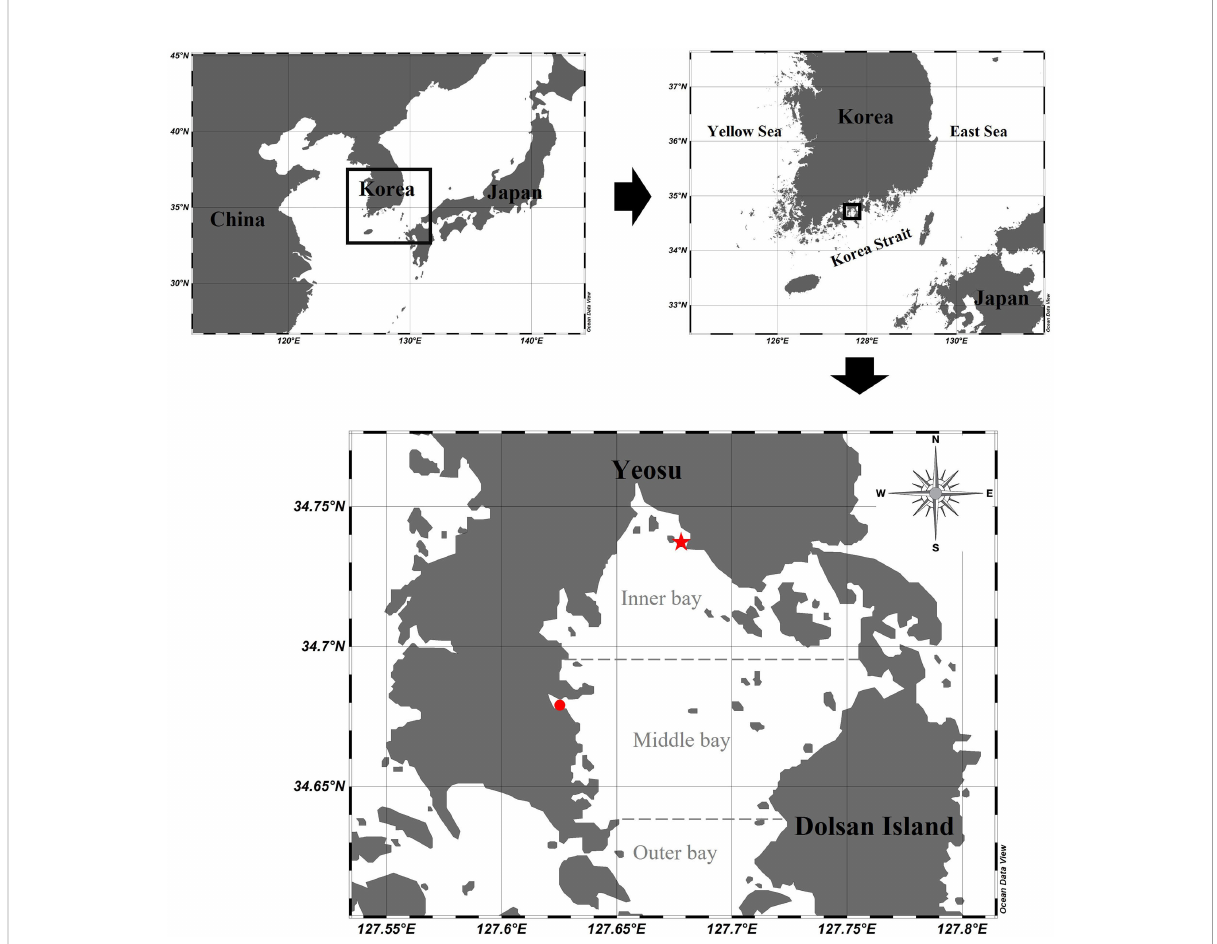
FIGURE 1 Sampling stations in Gamak Bay: a red star dot for the inner bay station and a red circle dot for the middle bay